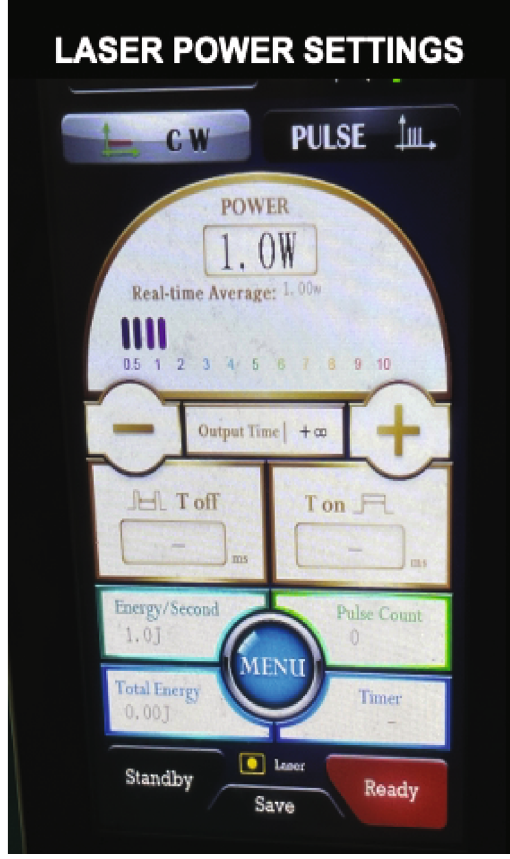
Figure 4: The laser unit with power